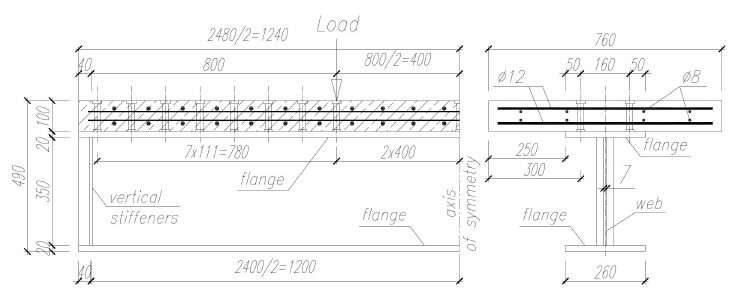
Figure 3. Parameters of the investigated steel beams with a sinusoidal web bonded to a concrete slab (dimensions in